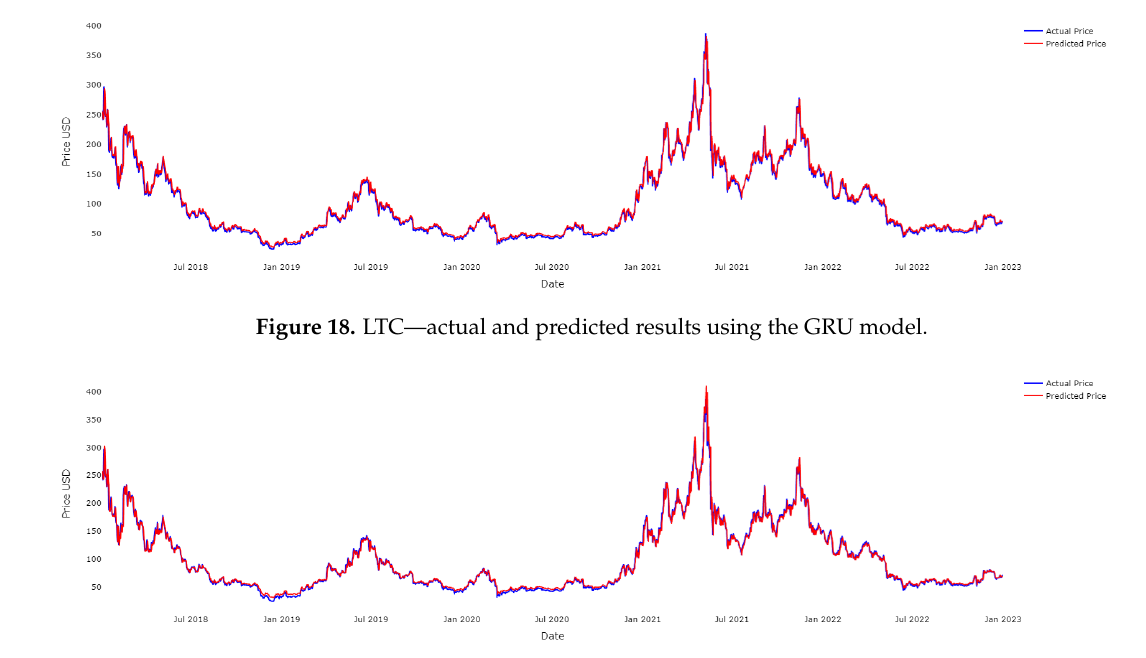
Figure 19. LTC—actual and predicted results using the LSTM model.